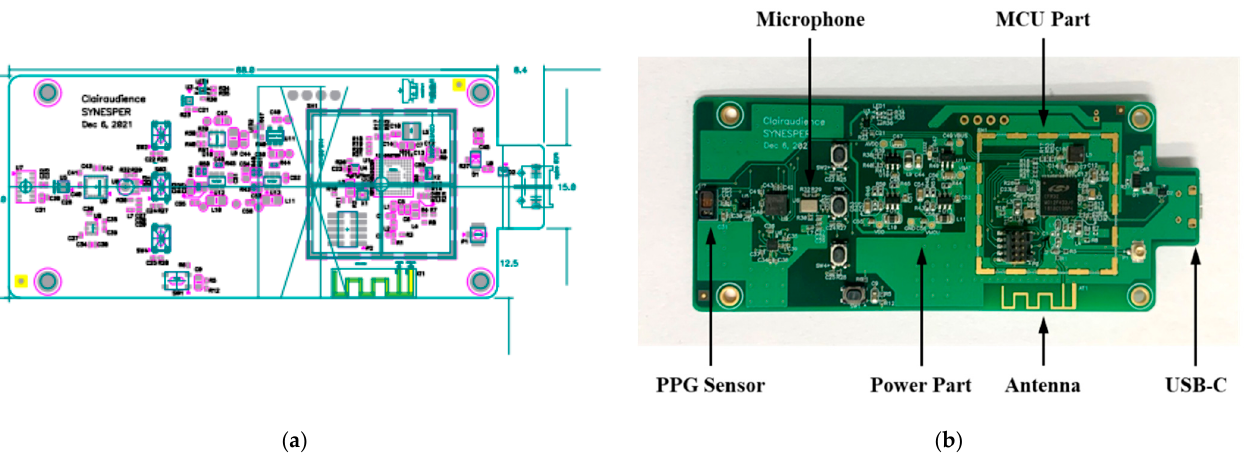
Figure 2. Proposed smart stethoscope PCB manufacture: ( a ) PCB artwork design; ( b ) Manufactured PCB.